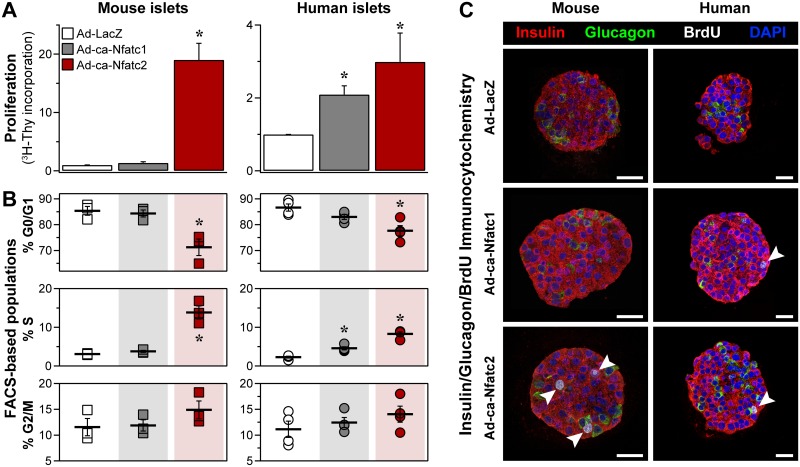
NFAT triggers β-cell proliferation in mouse and human islets.Adenoviruses (Ad) were used to overexpress constitutively active (ca) Nfatc1 or Nfatc2 in human and mouse islets; Ad-LacZ was used as the negative control. Cellular proliferation was monitored by incorporation of [3H]-thymidine into islet DNA (A), FACS-based analysis of cell cycle phases (B), and incorporation of BrdU (white arrow heads) into islet cells that were co-stained for insulin or glucagon to identify β-cells and α-cells respectively (C). Thymidine incorporation measurements were conducted on 5 and 3 separate mouse and human islet preparations, respectively. Immunofluorescent images are representative of >30 islets (BrdU) per adenoviral treatment collected from 5 mice, or 3 human islet preparations. FACS analysis of mouse islets was performed on three separate occasions, each using a pool of ~300 islets per mouse (B6) collected from 5 or more mice per adenoviral treatment; analysis of human islets was performed on 4 separate human donor preparations, each with >6000 islets per adenoviral treatment. *, P < 0.05 relative to LacZ for N ≥ 3. Scale bars in C, 25 μm.